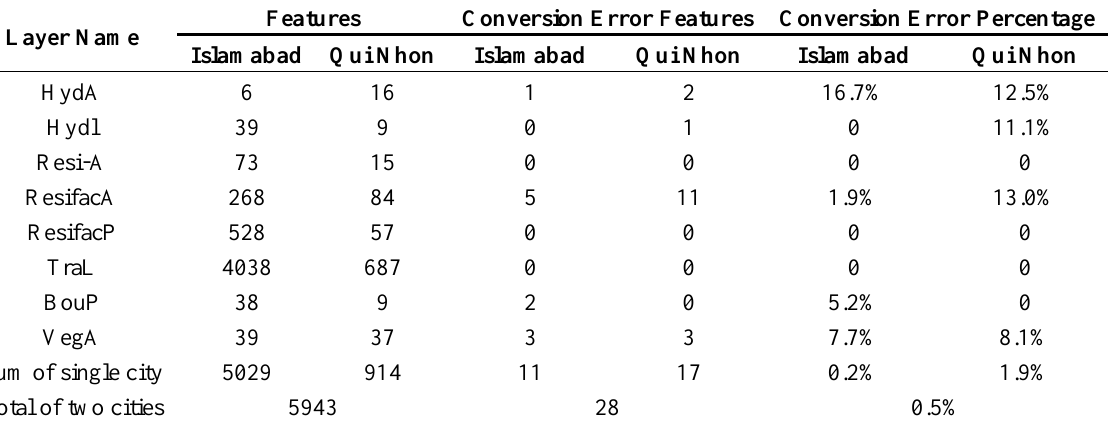
Table 3. Sum of model conversion